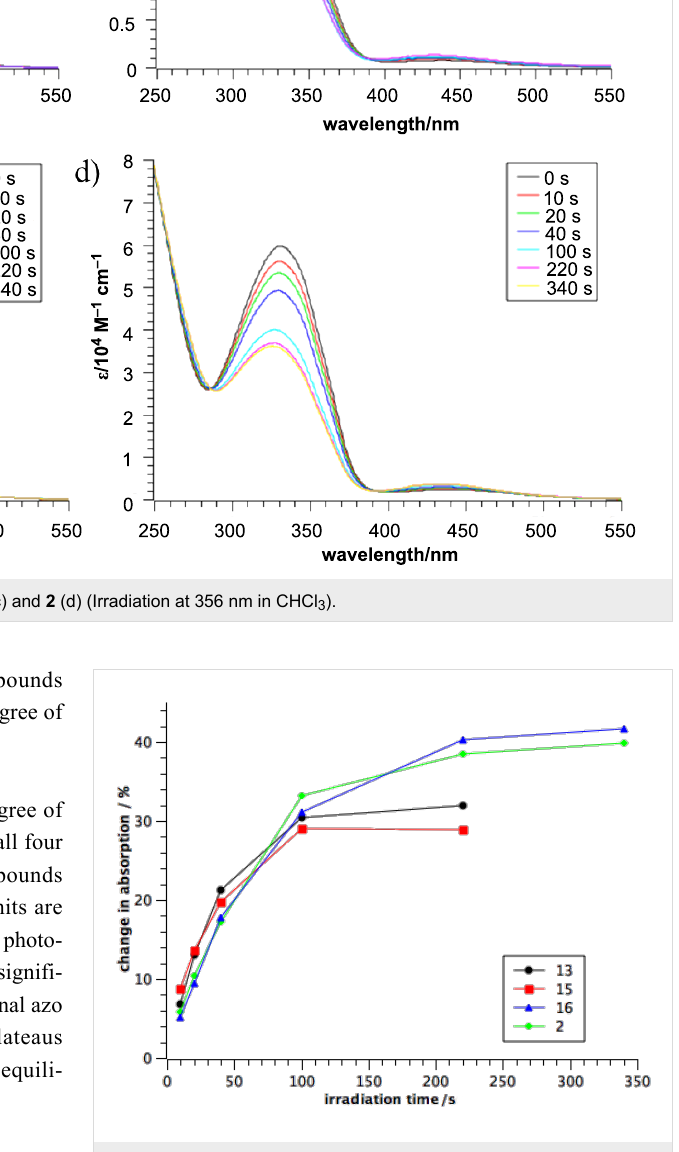
Figure 4: Comparison of the absorption as well as the photostationary state of compounds 13 , 15 , 16 , 2 .